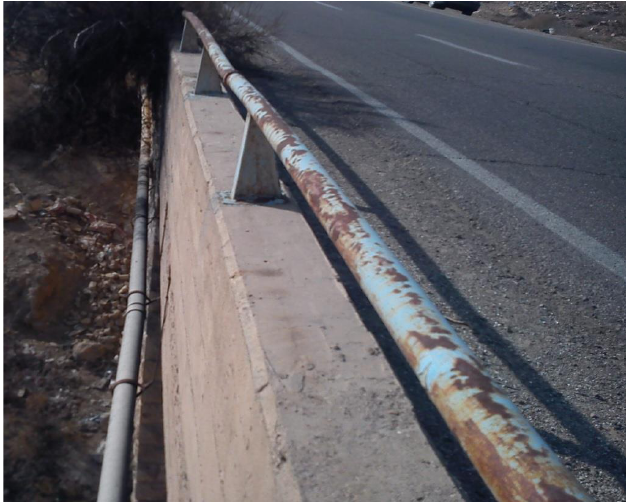
Figure 18. Safety and drainage issues in bridge No. 4.